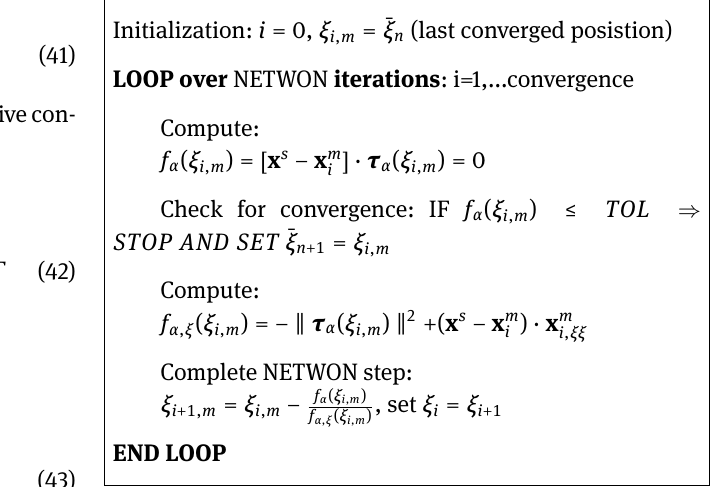
= ¯ ξ (last converged posistion) n i , m